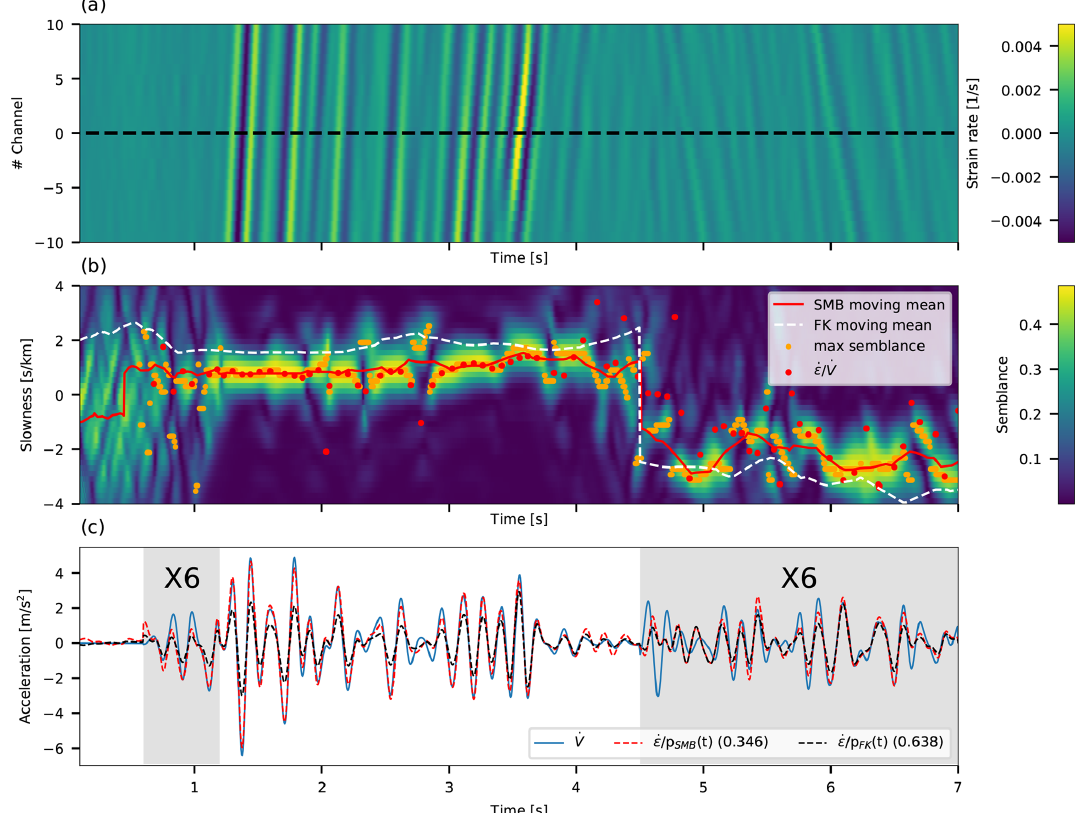
Figure 3. Slant-stack conversion for channel no. 220 of the simulated data. (a) Strain-rate time series for 21 adjacent traces centered around channel no. 220 (dashed black line). (b) Slowness as a function of time color coded by semblance values for channel no. 220. Slowness corresponding to the maximum semblance, and smoothed slowness are plotted in orange circles and a red curve, respectively. Smoothed slowness derived from FK-based analysis is indicated with a dashed white curve. Red dots correspond to the ratio between strain rates and accelerations, both differentiated from the simulated velocity waveforms. (c) Accelerations that are time-differentiated from simulated velocities (blue curve) compared with accelerations that are space-differentiated from simulated velocities and converted using semblance- derived slowness (red curve) and FK-derived slowness (black curve). Standard deviations of the residuals between converted strain rates (red and black curves) and time-differentiated velocities (blue curve) are indicated in the panel legend. The signals in the gray regions have been amplified by a factor of 6 for easy comparison of low-amplitude